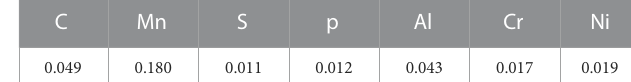
TABLE 2 Chemical composition of tested steel. TABLE 3 Chemical composition of the sample (wt.%).